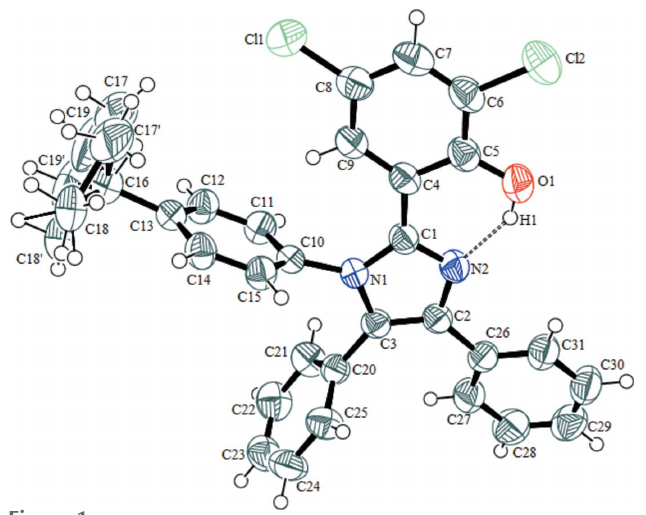
Figure 1 The molecular structure of the title compound with displacement ellipsoids drawn at the 50% probability level. The hydrogen bond is indicated by a double-dashed